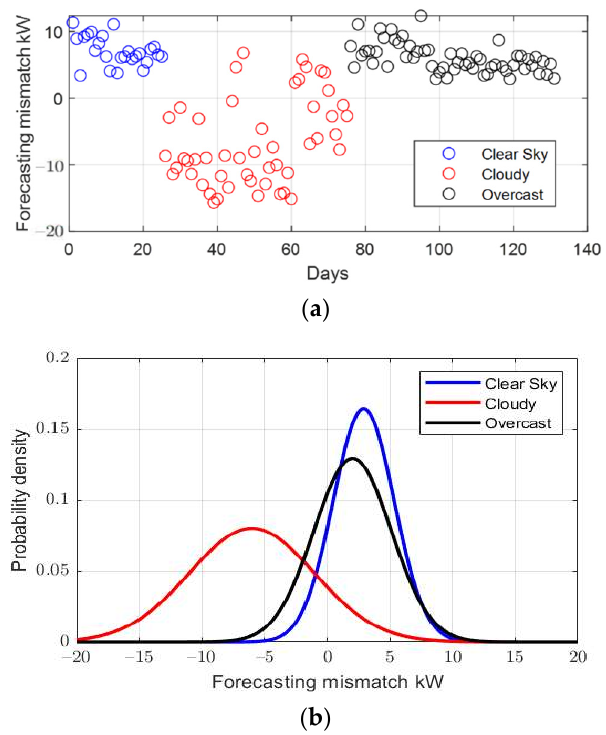
Figure 1. Uncertainty model of the forecasting mismatch: ( a ) daily average forecasting mismatch data; ( b ) regression of the forecasting mismatch by weather conditions.